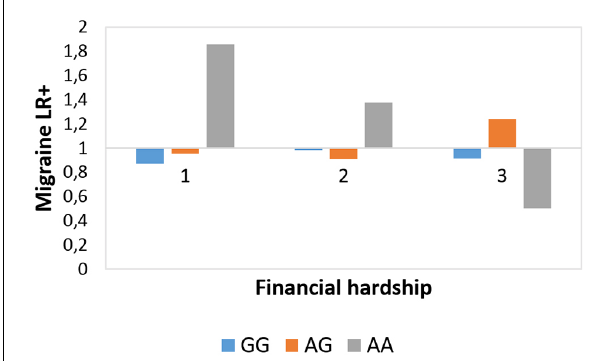
FIGURE 3 | Rs10462028 × financial hardship effect on migraineID in the Budapest subsample. The interaction effect between CLOCK rs10462028 and financial hardship on migraineID in the Budapest subsample is shown. FINANC, financial hardship; LR+, positive likelihood ratio. Number of cases in FINANC_1 ( living very/quite comfortably ) group: GG = 269, AG = 242, AA = 67. Number of cases in FINANC_2 ( just getting by ) group: GG = 106, AG = 117, AA = 24. Number of cases in FINANC_3 ( finding it difficult/not able to make ends meet ) group: GG = 23, AG = 19, AA = 6.